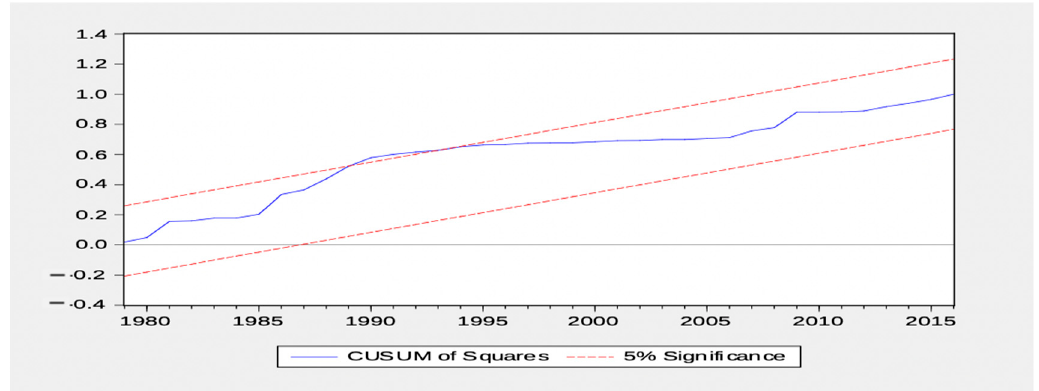
Figure A4. CUSUM Test (UAE).